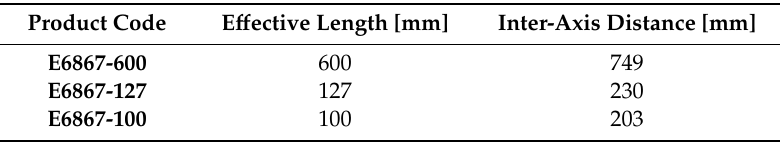
Table 1. 3 He PSD tube lengths.